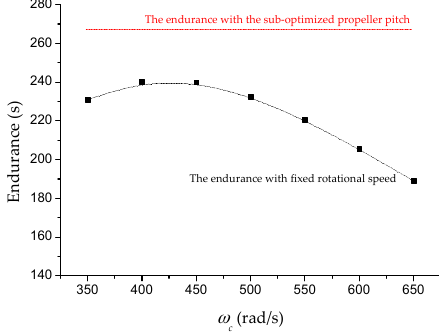
Figure 9. Experimental results of the conventional method with ω cj “ 400 ( j “ 1,2,3,4): ( a ) v zc and v z ; ( b ) e vz ; ( c ) ω c 1 and ω 1 ; ( d ) L 1 ; ( e ) u 1 ; ( f ) α 1 . Other propellers have similar characteristics.